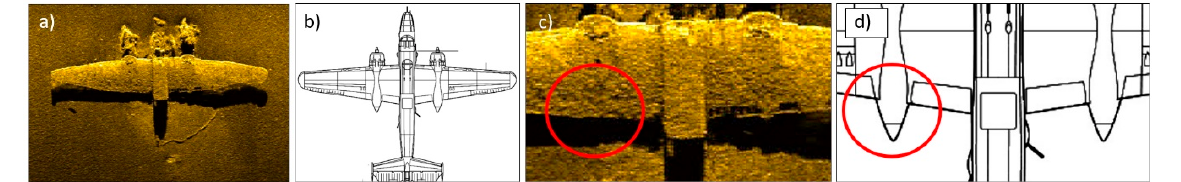
Figure 12. Comparison of the sonar image of the wreck with the B-25 Mitchell bomber: ( a ) sonar imagery of the wreck; ( b ) the floor plan of the B-25 Mitchel bomber; ( c ) identifying the wing feature in the sonar image; ( d ) identification of the engine on the construction plans.